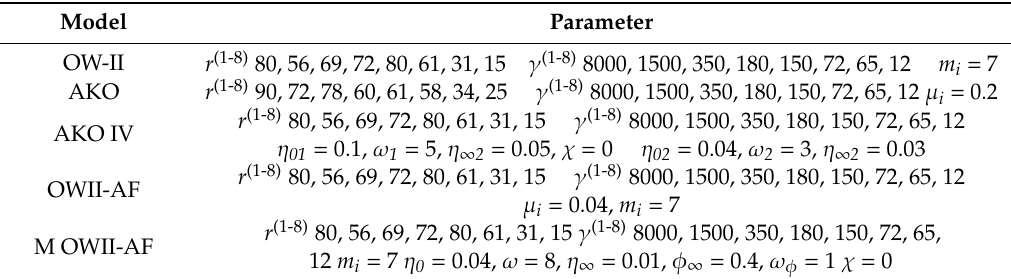
Table 3. Parameter determination of di ff erent